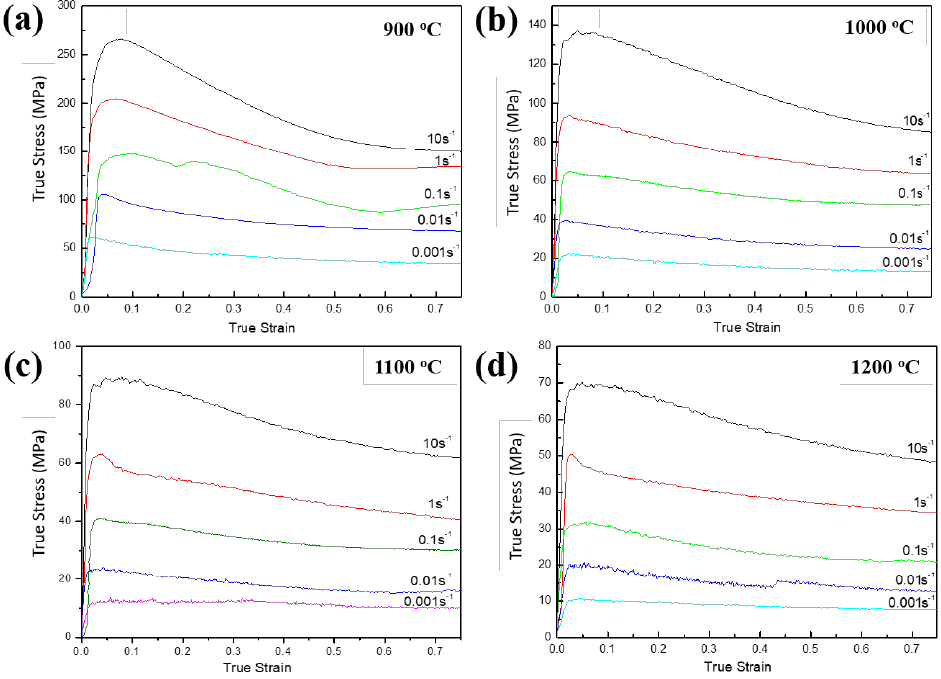
Figure 3. True stress-true strain curves of the UF-TiB/Ti-6Al-4V composites after being compensated